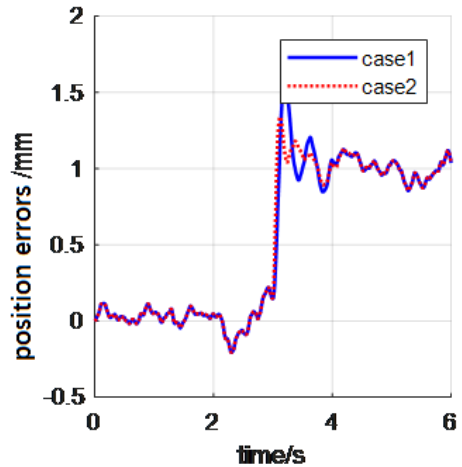
Figure 8. The position tracking